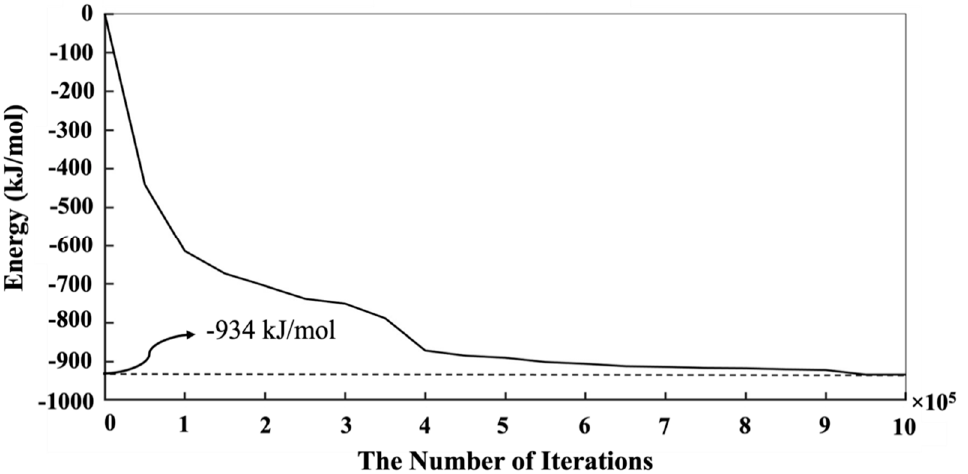
Figure 4. The energy evolution of the system to reach the equilibrium condition to obtain pre- condensation of the silicate solution (after 1 million iterations), where metakaolinite is not yet involved.